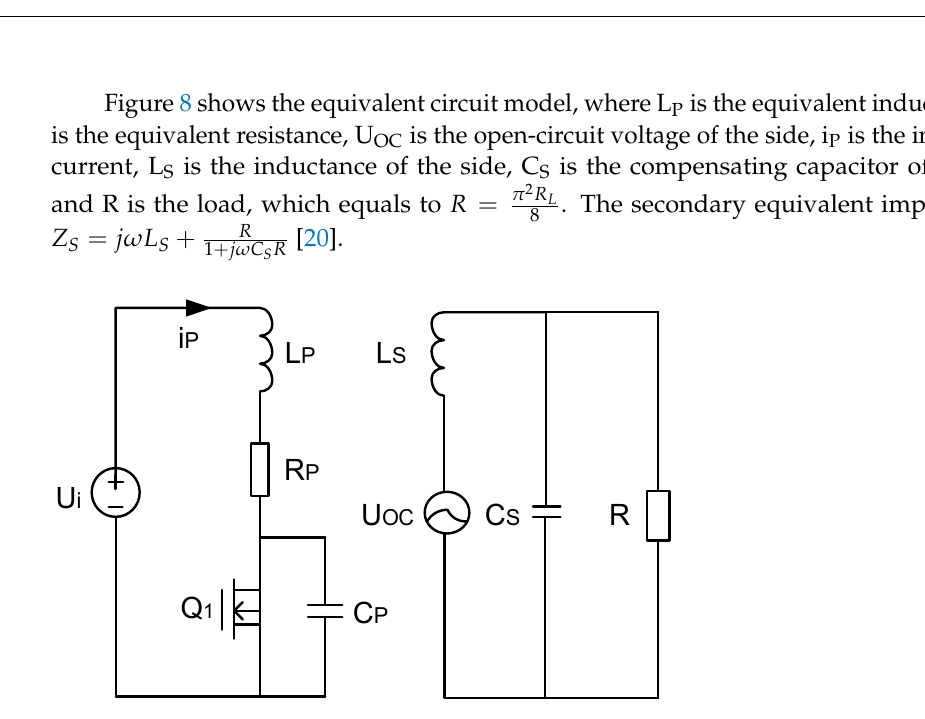
Figure 8. Equivalent circuit diagram of primary and secondary sides .